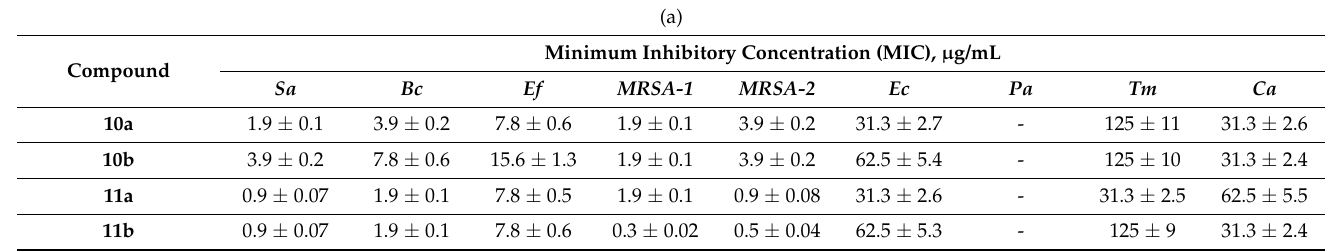
Table 2. (a) Antimicrobial and fungicidal activity of QPSs: minimum inhibitory concentrations. (b) Antimicrobial and fungicidal activity of QPSs: minimum bactericidal and fungicidal concentrations.